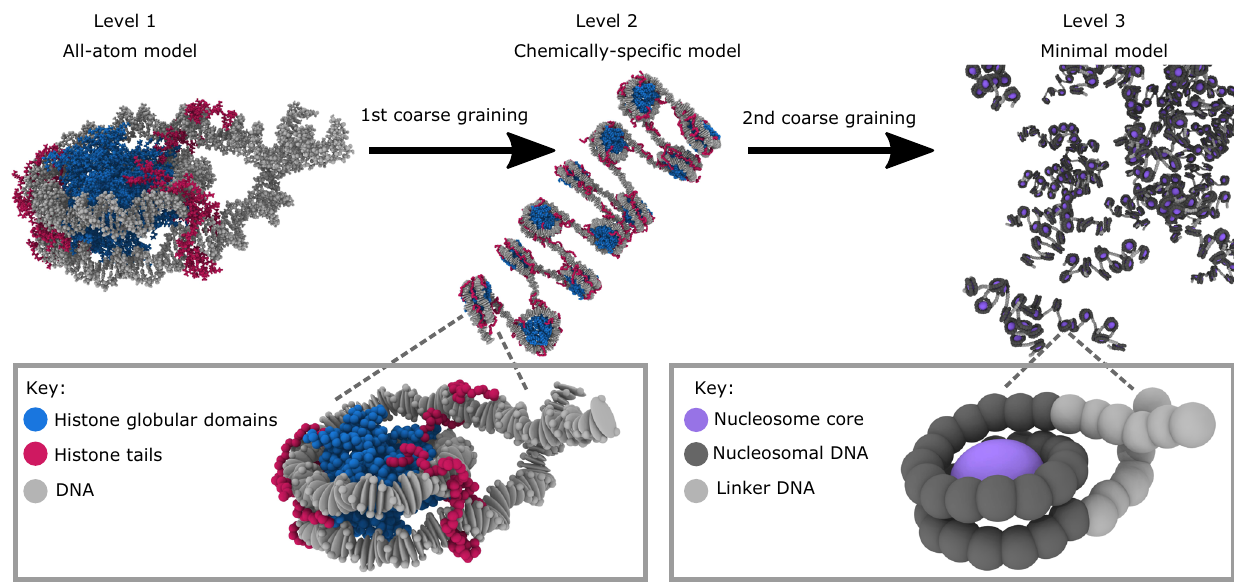
Fig. 1 Schematic representation of our chromatin multiscale toolkit spanning three levels of resolution. (Level 1) Our high-resolution layer: Atomistic MD simulations of DNA and nucleosomes to identify key physicochemical information. An atomistic nucleosome is depicted with atoms in the histone globular domains colored in blue, in the histone tails in magenta, and in the DNA in gray. (Level 2) Our mid-resolution layer: Debye-length replica-exchange MD simulations of our chemically-speci fi c coarse-grained chromatin model; representing DNA at the base-pair level (one gray ellipsoid per base-pair) and modeling histone tails (one magenta bead per amino acid) and histone globular domains (one blue bead per amino acid) at the residue level. This model links elementary properties of nucleosomes to mesoscale behavior of oligonucleosomes by accounting for the following key molecular features from Level 1: DNA mechanical properties, secondary structure of the histone globular regions, fl exibility of histone tails, and the size, shape, electrostatics, and hydrophobicity of individual amino acids and base pairs. (Level 3) Our low-resolution layer: Direct coexistence simulations of our minimal coarse-grained chromatin model designed to investigate the phase behavior of a few thousand interacting nucleosomes. The histone core is treated as a single interaction site (purple bead) with parameters from internucleosome potential of mean force simulations from Level 2. The nucleosomal DNA (dark gray beads) and the linker DNA (light gray beads) are described explicitly (1 bead = 5 bp) with our minimal RBP-like model parameterized from free DNA simulations from Level